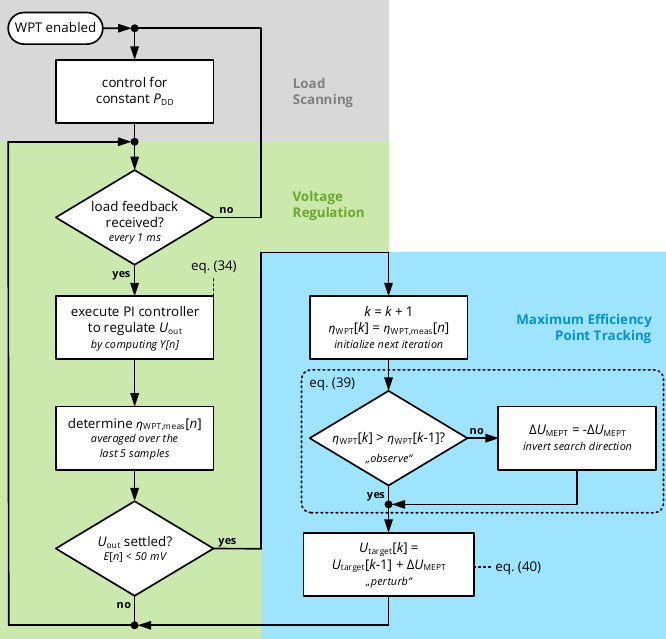
Figure 9. Flowchart of the algorithms for voltage regulation and maximum efficiency point tracking. The voltage controller is directly started after receiving a feedback signal from a wireless receiver. Once settled, the maximum efficiency point tracker is enabled, which modifies the setpoint of the voltage controller in the direction of increasing